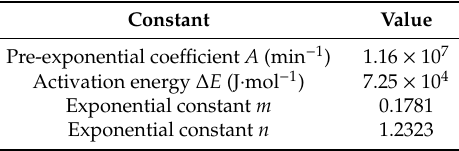
Table 2. Cure kinetic constants of 3900-2 resin